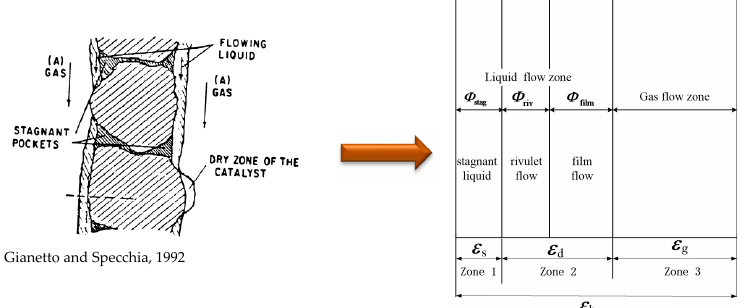
Figure 1. Parallel zone model describing liquid flow texture in a trickle bed [45]. The volumetric fractions of the three liquids are denoted as Φ stag , Φ film and Φ riv